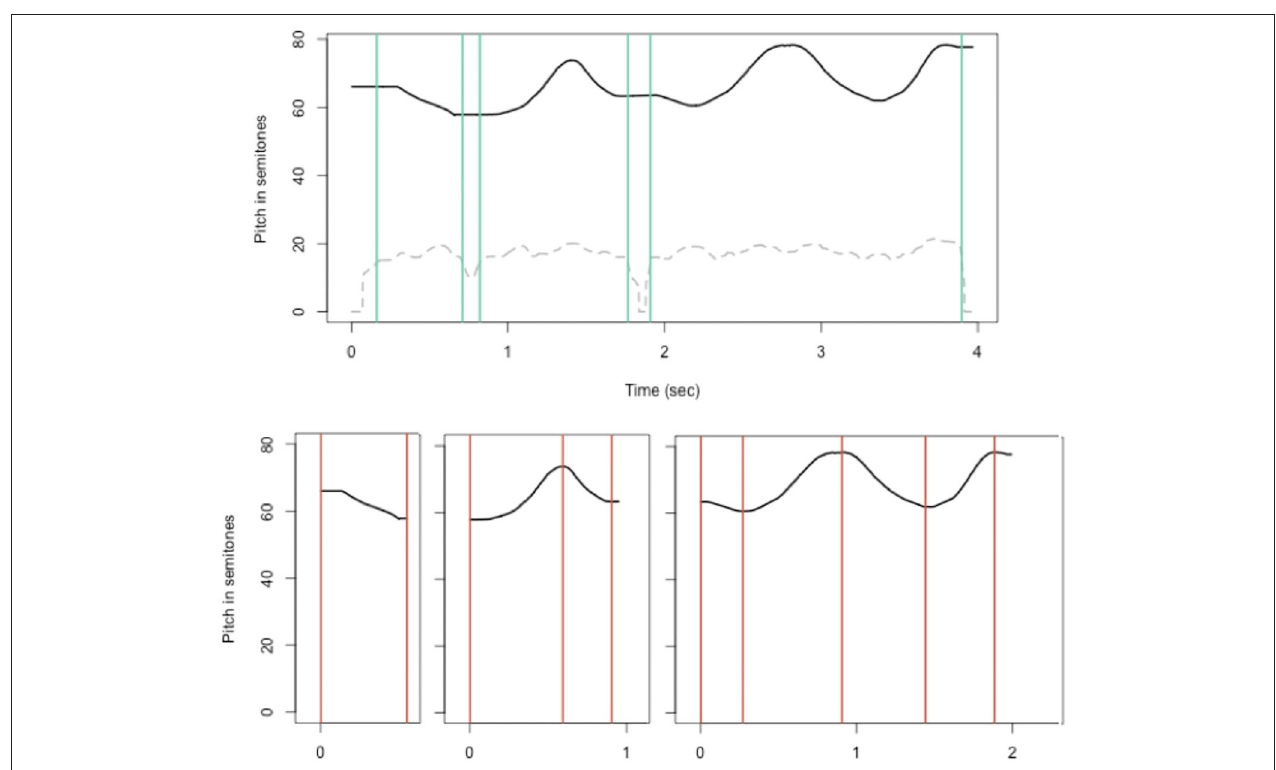
FIGURE 3 | A whistle, plotted as pitch track on a semitone scale (black line) segmented into sounding and silent parts (borders shown in green vertical lines), based on the intensity track as shown by the dashed grey line [ranging from 0 (silent) to 92.6, actual value divided by 4 to fit better in plot]. Below, the separate segments are annotated to indicate pitch “targets” (coral vertical